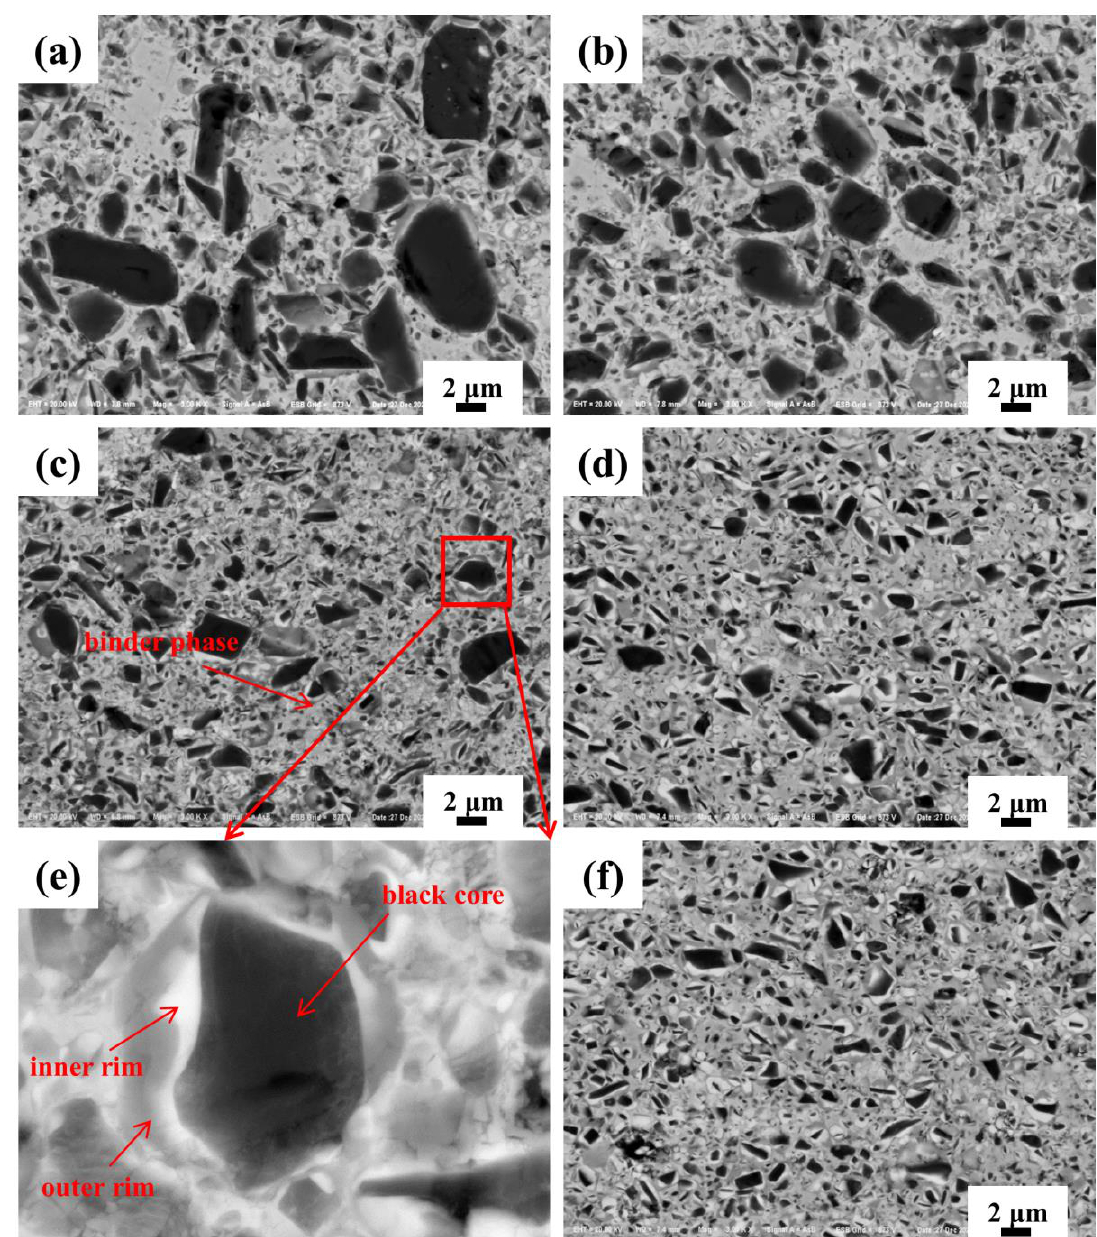
Figure 3. SEM/BSE micrographs of Ti(C,N)-based cermets with different SiC p content: ( a ) 0.0 wt.%; ( b ) 1.0 wt.%; ( c ) 2.0 wt.%; ( d ) 2.5 wt.%; ( e ) a partial enlargement of ( c ). ( f ) 3.0 wt.%.